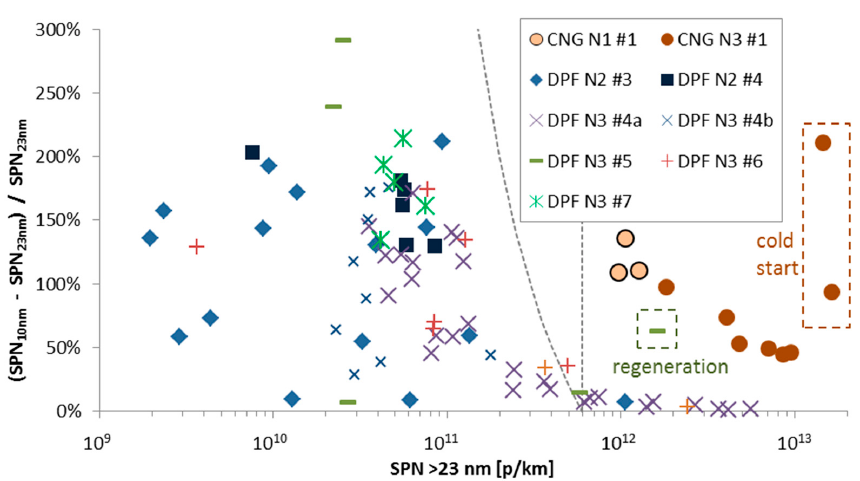
Figure 9. Sub ‐ 23 nm fraction (corrected for particle losses) in function of the SPN >23 nm emissions. Vertical dashed line indicates a limit of 6 × 10 11 p/km for particles >23 nm in diameter (note that it is only an indication as the limit applies only to engines and is expressed in p/kWh). The other line indicates the same limit for particles >10 nm in diameter.